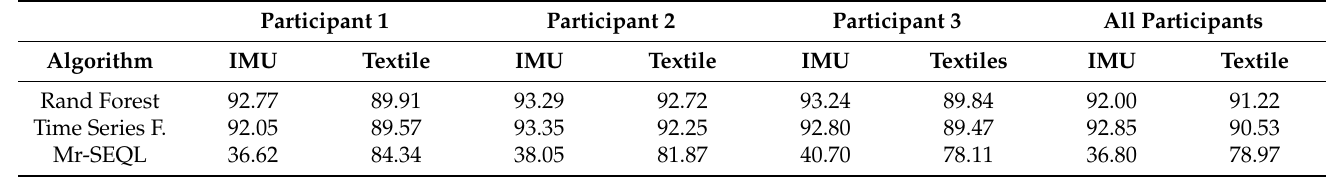
Table 4. Precision percentage achieved with each participant and type of sensors.